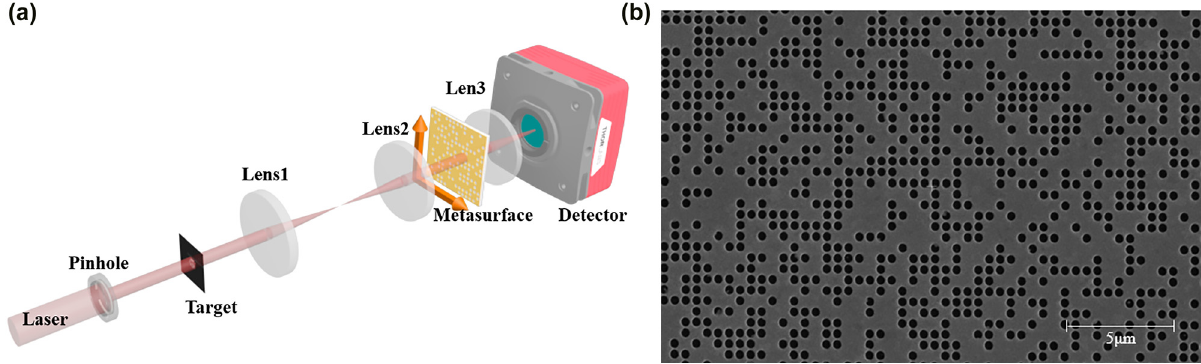
Figure 5: The experimental setup and the scanning electron microscopy image of our sample. (a) The experimental setup of our SPI scheme with metasurface. The focal length of lens 1 and lens 2 is 150 mm, forming a 4f system. Lens 3 is a focusing lens with a focal length of 100 mm. (b) Scanning electron microscopy image (SEM) of fabricated sample. Scale bars, 5 μ m.